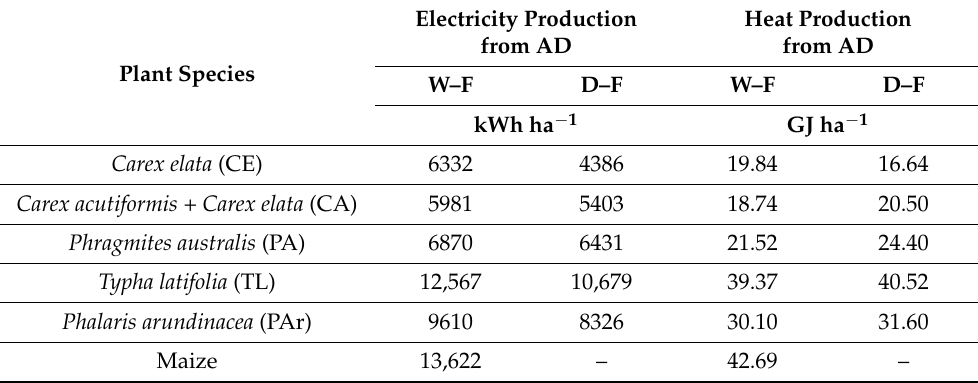
Table 5. Energy from anaerobic digestion (AD) of paludi-biomass from highly productive paludicul- ture calculated on the basis of BMP results and assumed high yields